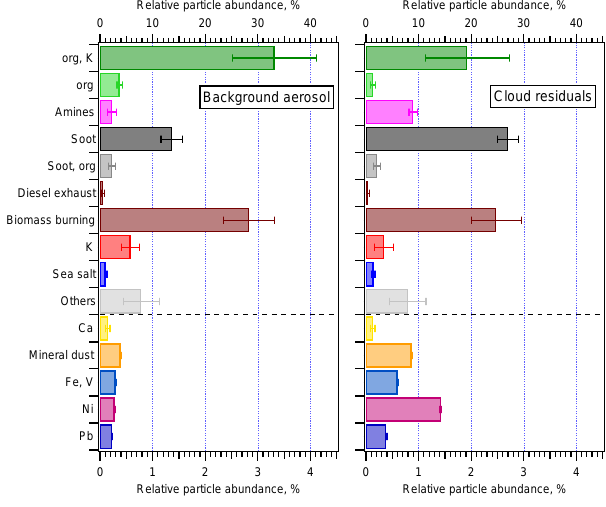
Figure 6. Aerosol composition of out-of-cloud aerosol (left) and cloud residual particles (right) for the entire HCCT-2010 cam- paign. Uncertainties of the clustering were estimated according to Sect. 2.4.2. In case of particle types determined by the marker peak method (Sect. 2.4.3) uncertainties are based on Poisson statistic. Number of analysed particles: out-of-cloud aerosol: 164595, cloud residues: 13157. Note that the scale is expanded by a factor of 10 below the dashed line (bottom axis), particle abundances above the dashed line refer to the top